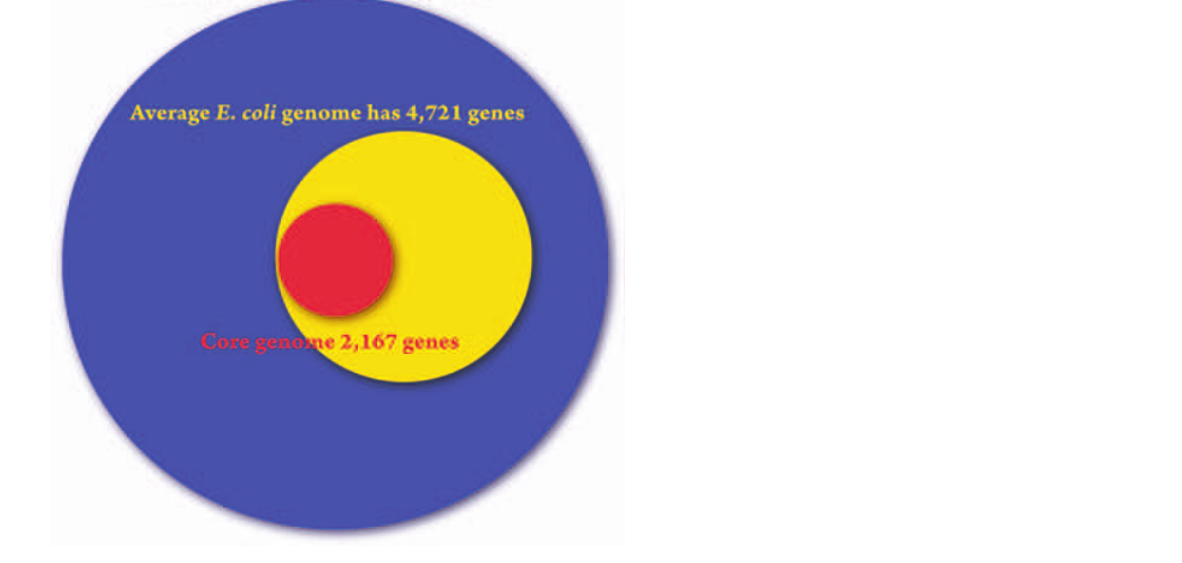
Figure 1. The breadth of genomic potential for E.coli . A Venn diagram of the pan-genome (blue), average genome (yellow), and core genome (red) of the sequenced E. coli strains according to Touchon et al.